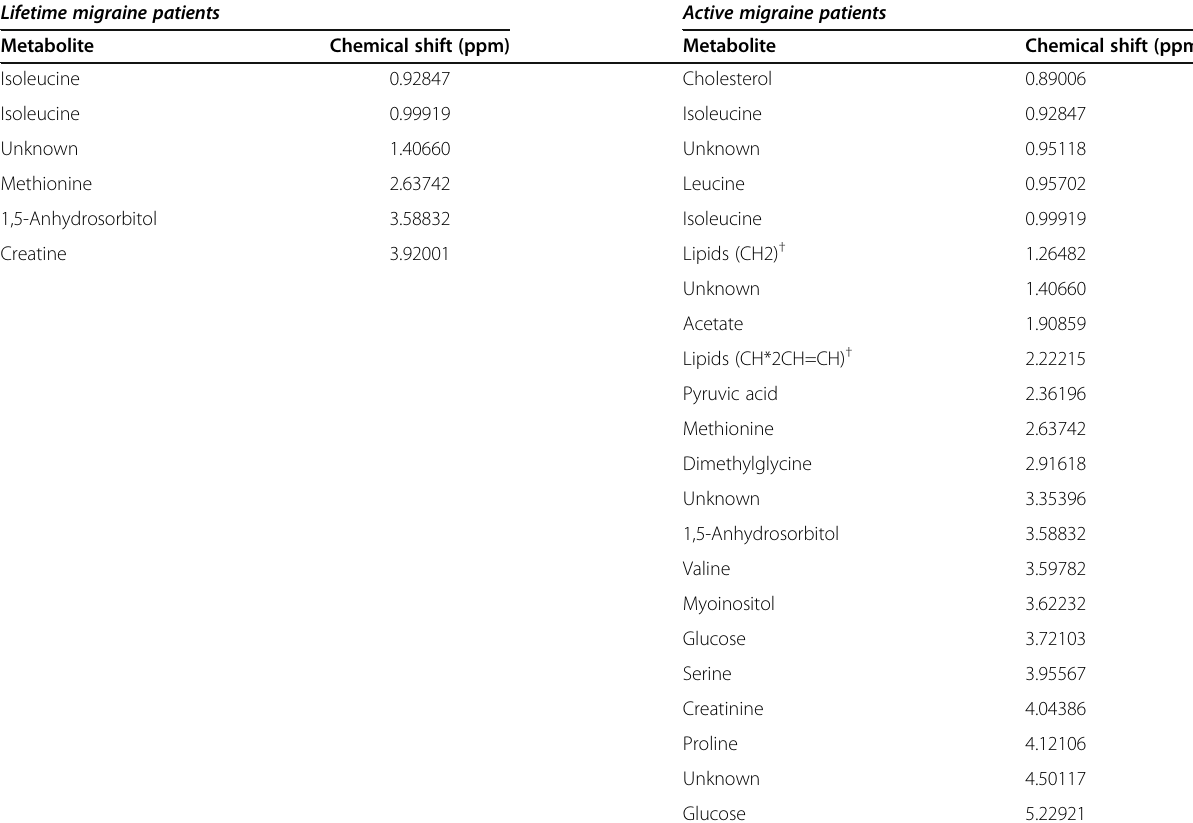
Table 2 1 H-NMR signals associated with lifetime migraine patients and active migraine